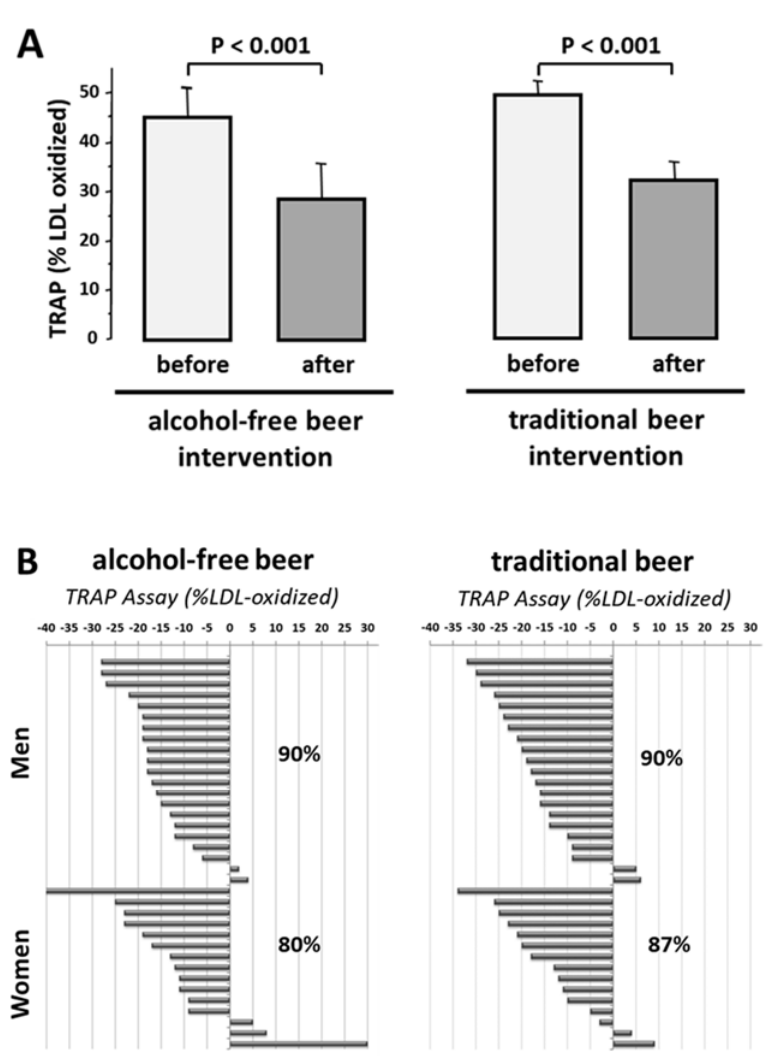
Figure 3. Effect of moderate beer consumption on HDL antioxidant capacity in subjects with overweight or obesity class-1. ( A ) Results are expressed as % of oxidized LDL referred to the value obtained in the absence of HDL. ( B ) Functional response of HDL to oxidative stress at individual level.